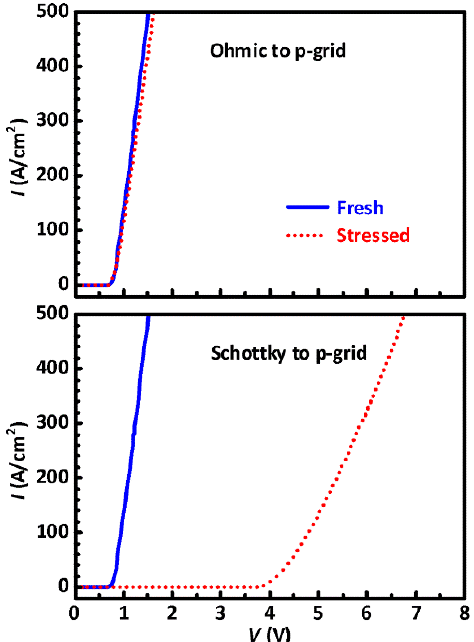
Figure 4. The I-V characteristics under initial and stressed states of the SiC JBS diode with Ohmic contact to the p-grids and that with Schottky contact to the p-grids.